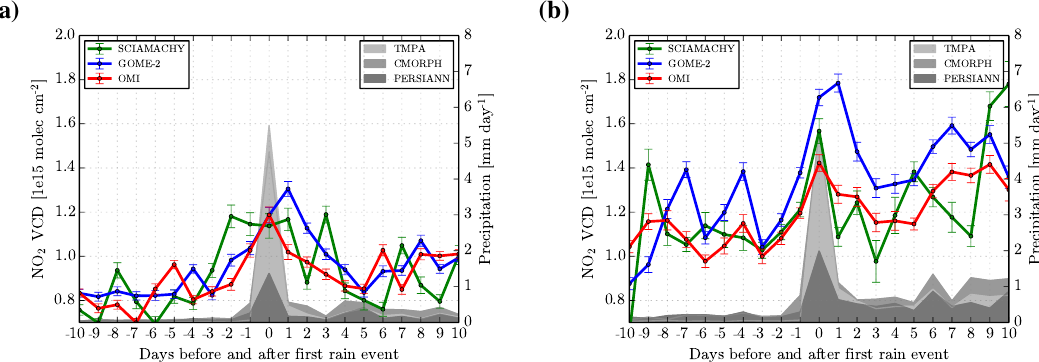
Figure 11. Same as Fig. 5d, but filtered for (a) northerly and (b) southerly winds. The filter criterion is fulfilled, if the wind direction at 600, 850 and 1000hPa is north or south,